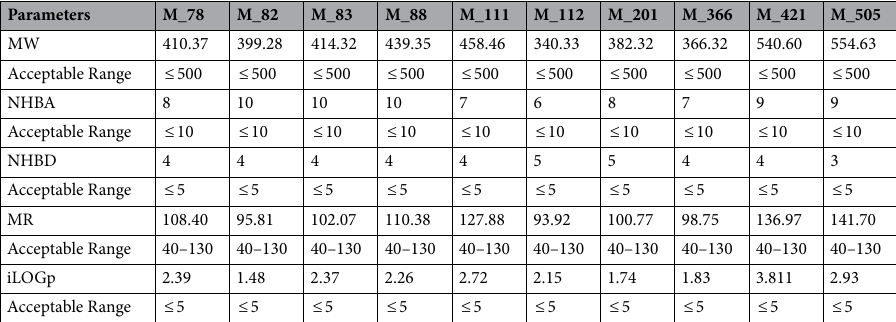
Table 2. Physiochemical parameters of selected SARS-CoV-2 M pro proposed inhibitors from mushrooms. The